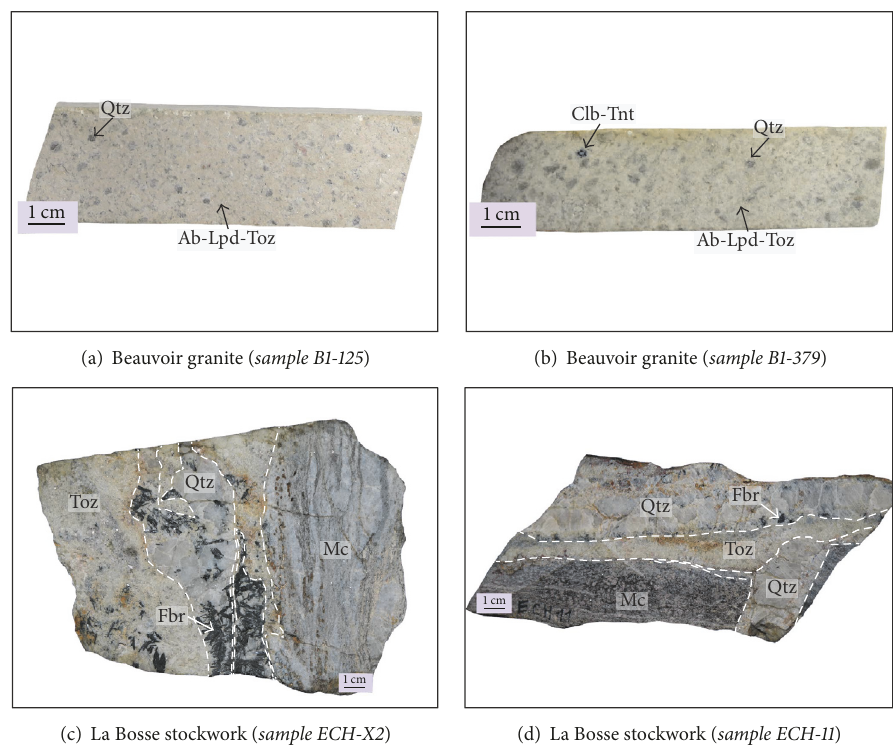
Figure 4: Photographs of the studied samples from the Beauvoir granite ((a), (b)) and the La Bosse stockwork ((c), (d)). Ab: albite; Clb-Tnt: columbite-tantalite; Fbr: ferberite; Lpd: lepidolite; Mc: micaschist; Qtz: quartz; Toz: